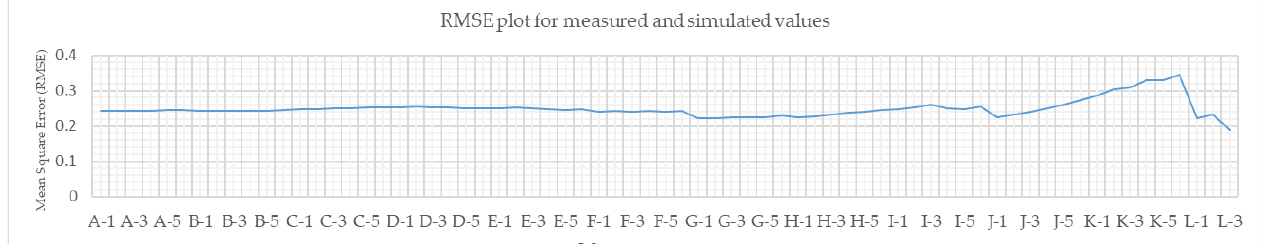
Figure 11. RMSE plot for measured and simulated values. The data for the graph were obtained through CFD simulations.